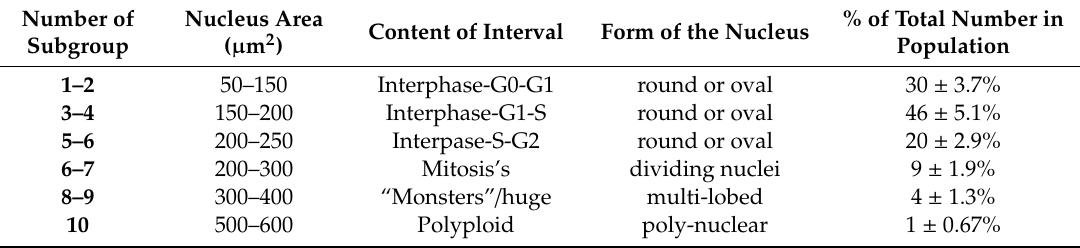
Table 1. Distribution of H1299 cell population based on nucleus area, size, and nuclear morphology. Subgroups formed are represented as percent of